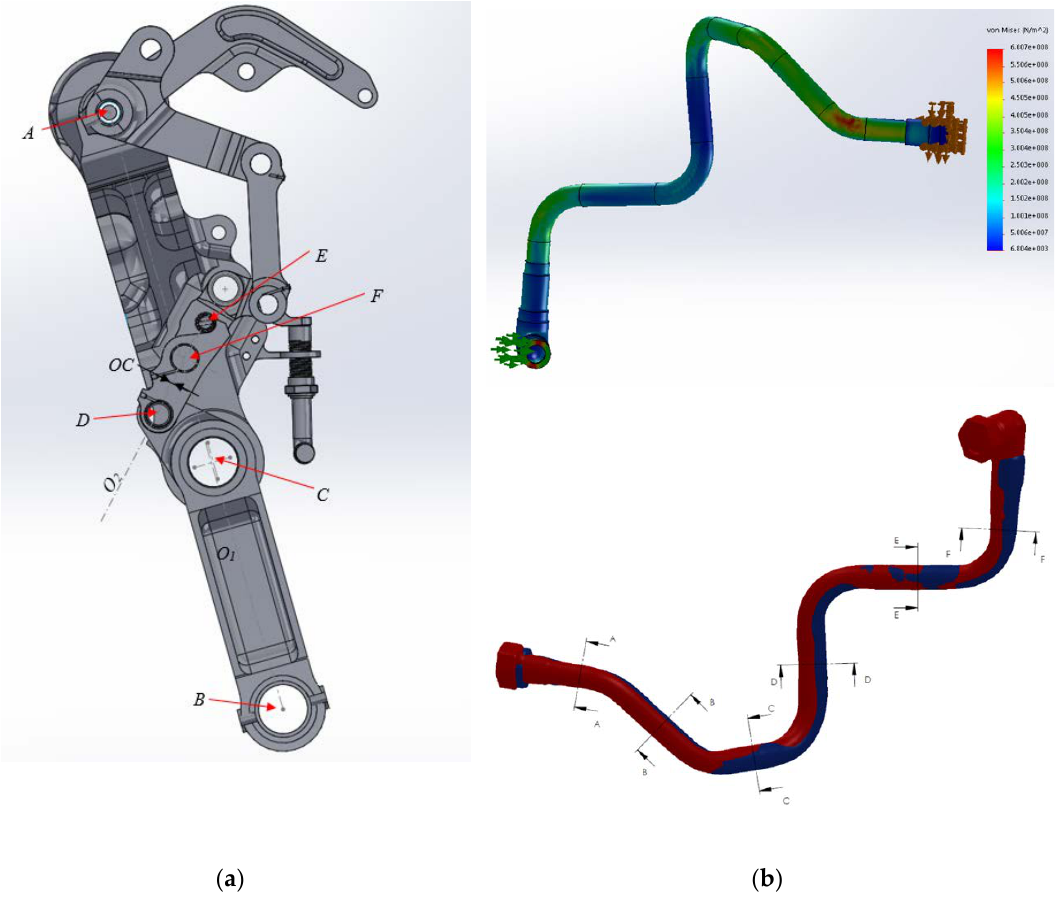
Figure 1. Examples of applying simulation methods in investigating air accident causes: ( a ) aircraft retractable landing gear strut kinematics, ( b ) stress concentration areas and the geometry of an aircraft hydraulic line.